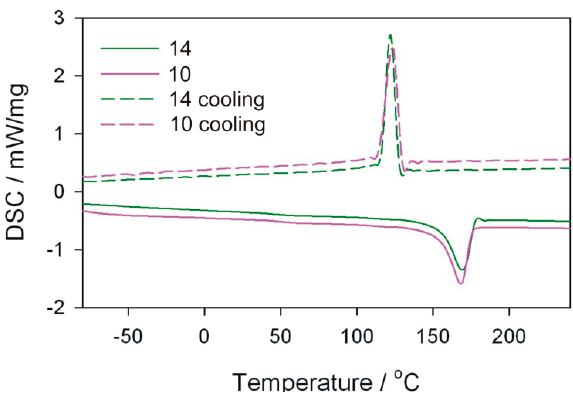
Figure 15. DSC curves for extrudate samples–layouts 10 and 14. Sample designations as in Table 1.